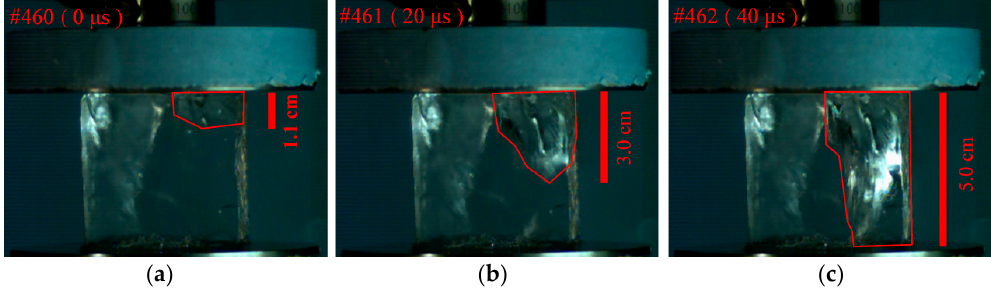
Figure 20. Sequence frames of a 5.0-centimeter-high ice sample in failure process, loaded vertically at a rate of 0.5 m ⋅ s − 1 and recorded at a frame rate of 50,000 fps: ( a ) #460; ( b ) #461; ( c ) #462.